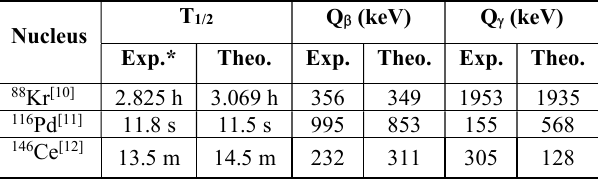
Table 1 Examples of calculated results by the QRPA approach comparing with the experimental data